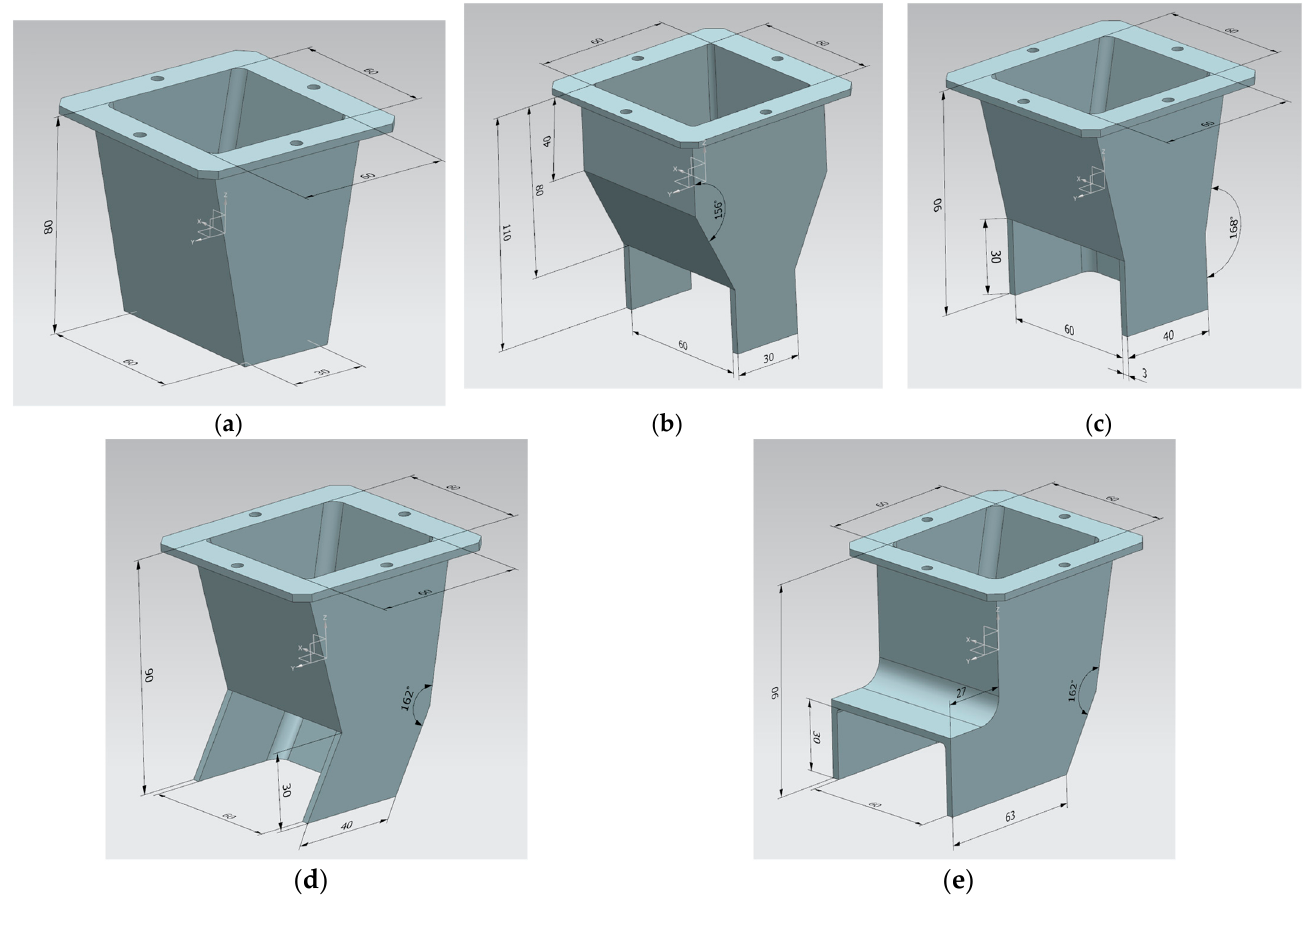
Figure 9. Types and details of nozzle (The unit of length is mm): ( a ) Nozzle#1; ( b ) Nozzle#2; ( c ) Nozzle#3; ( d ) Nozzle#4; ( e ) Nozzle#5.